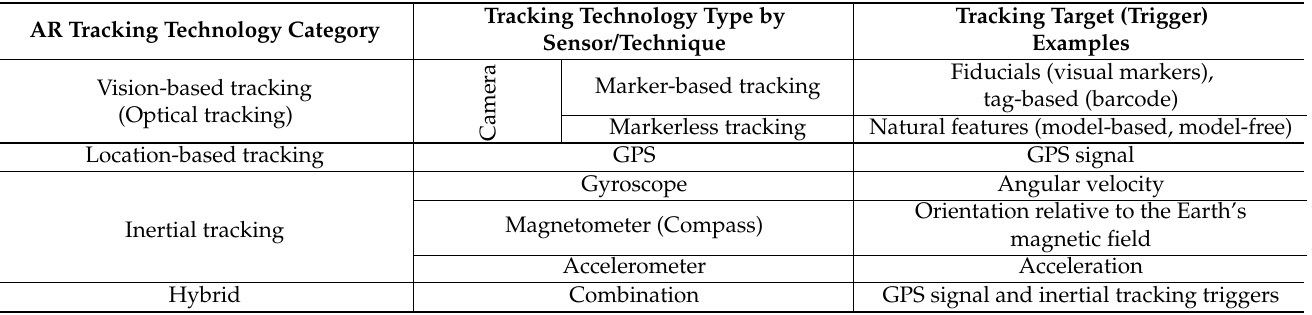
Table 1. AR tracking technology categorization based on the sensor/technique used for tracking in AR mobile tracking